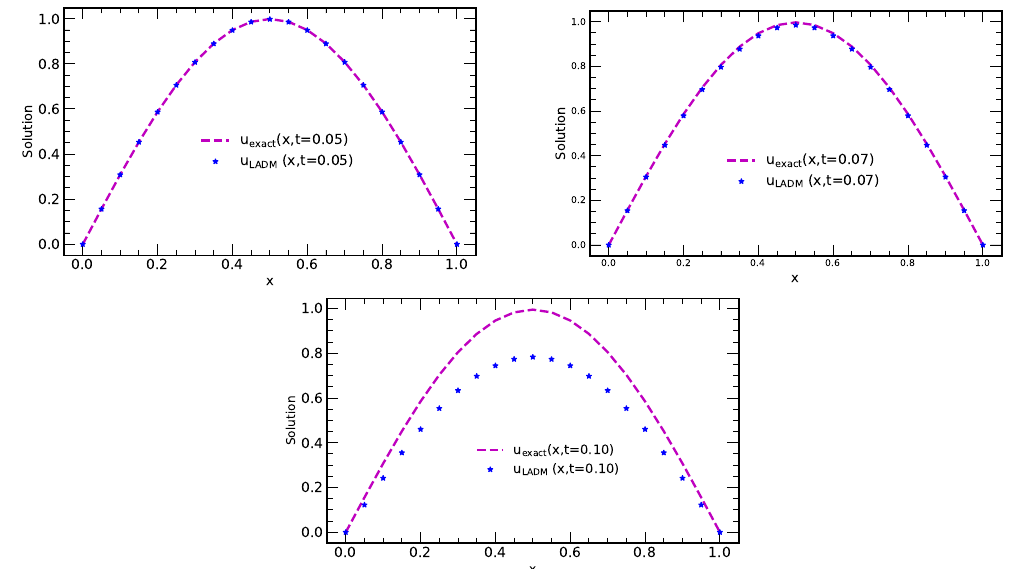
Figure 4. Plots of exact solution and solution using LADM vs. x at different t -values, t = 0.05,0.07,0.10 (for numerical experiment 2).